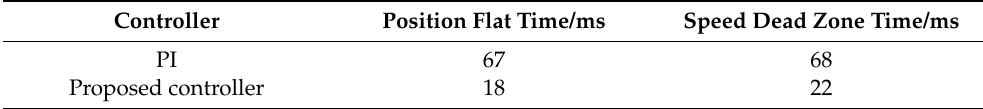
Figure 18. Curve of tracking ( a ) Position tracking curve; ( b ) Speed tracking curve. Table 4. Comparison of tracking performance of 0.9sin (0.9 π t).